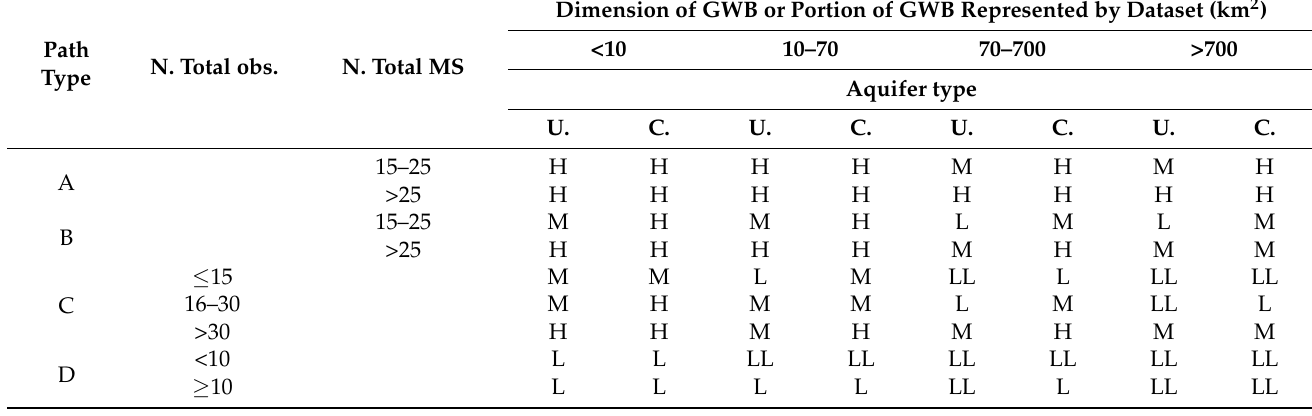
Table 2. Confidence level of the obtained NBL. U. = unconfined aquifer; C. = confined aquifer; H = high; M = medium; L = low; LL very low.